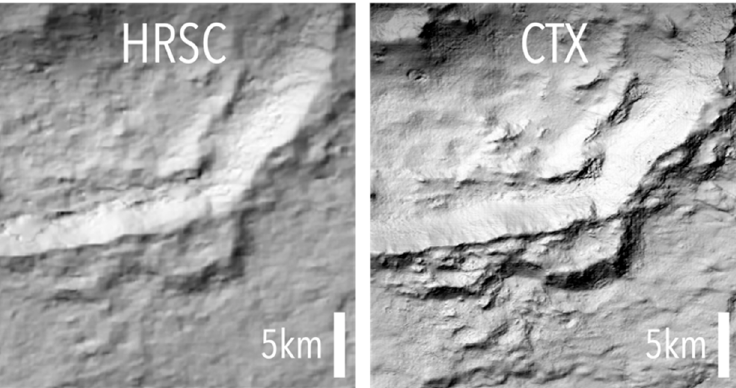
Figure 8. Visual comparison of the reconstruction of the edge of Tarq crater (southern midlatitudes) with a HRSC DTM at 50 m per pixel ( left ) and a CTX DTM at 12 m per pixel ( right ).